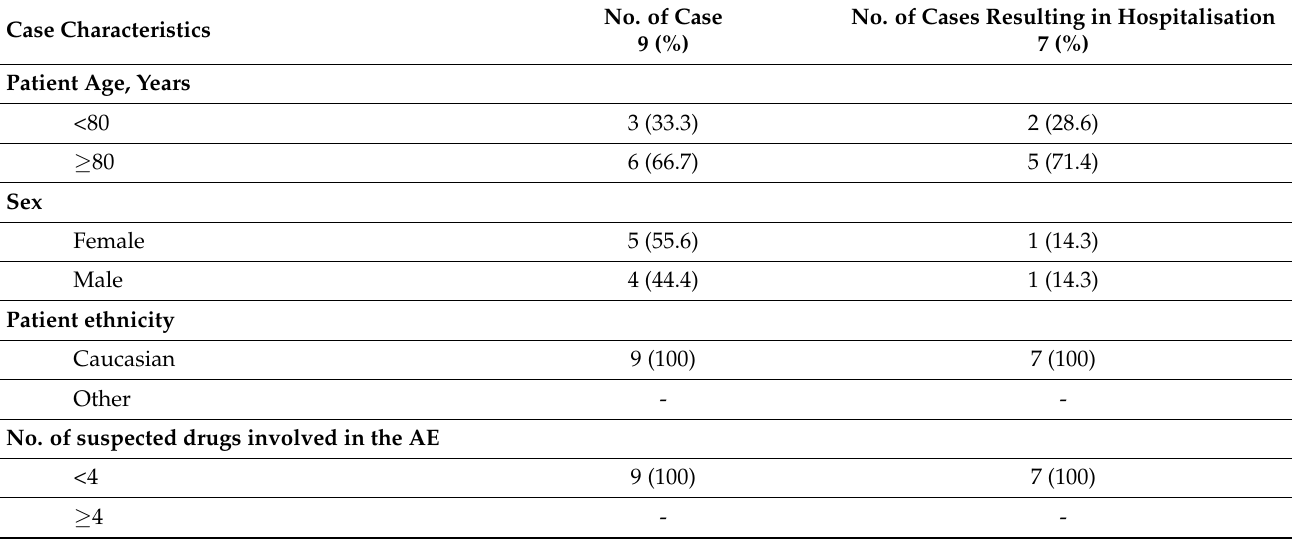
Table 5. Demographic characteristics of the nine cases with renal